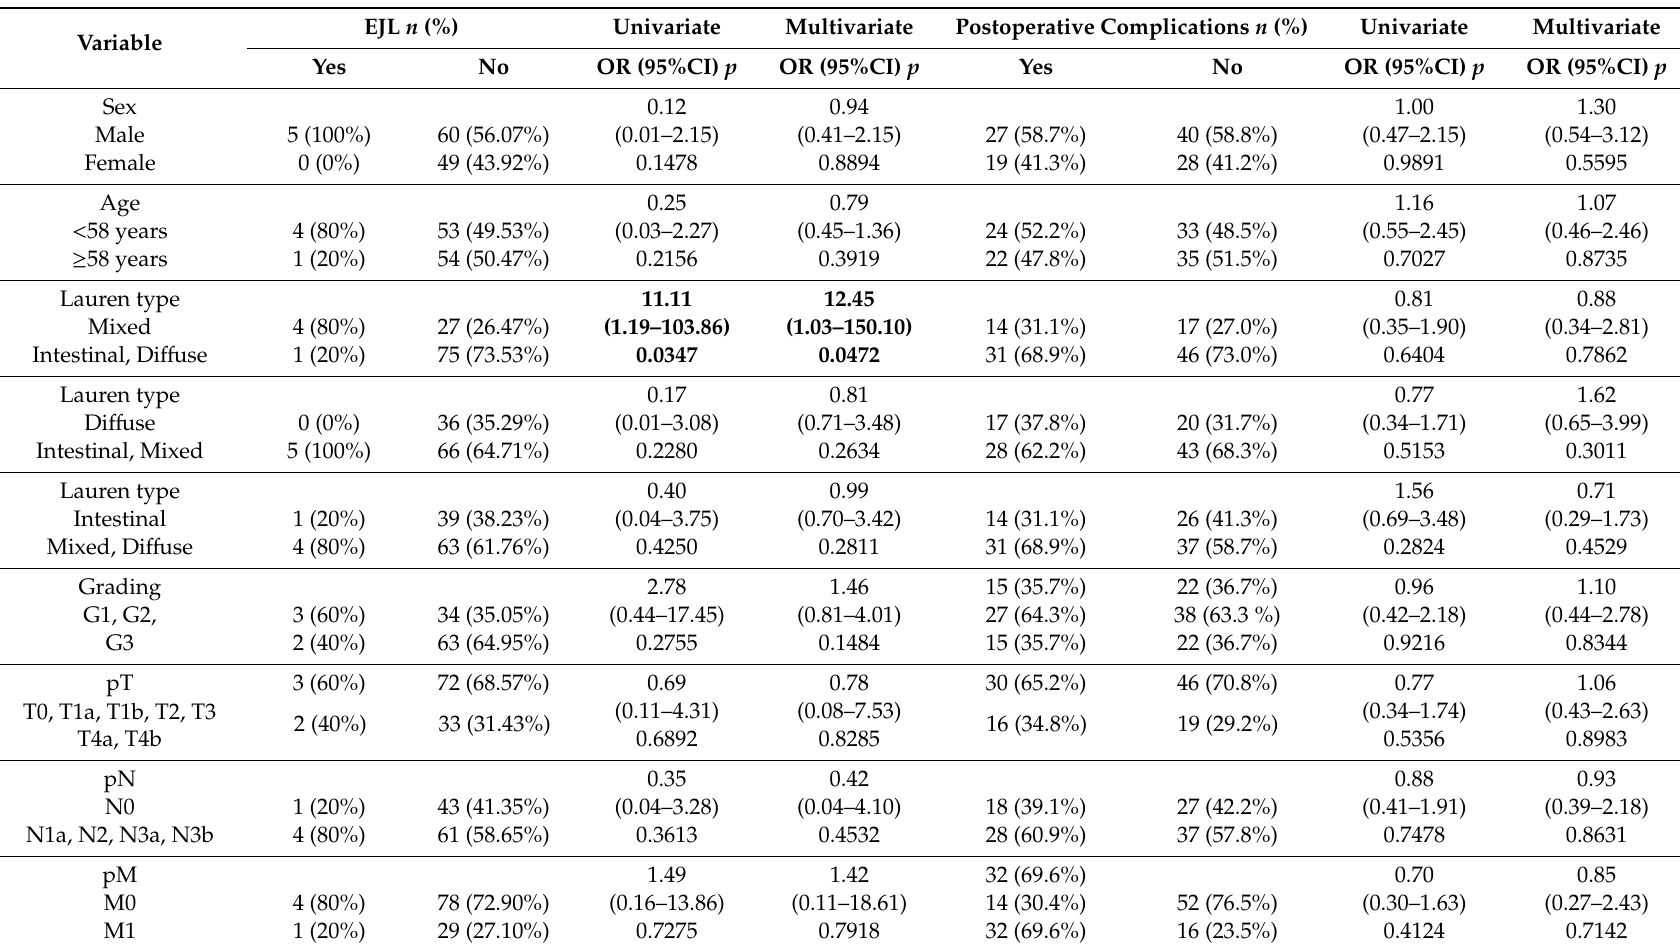
Table 2. Univariate and multivariate analysis of the risk of EJL and postoperative